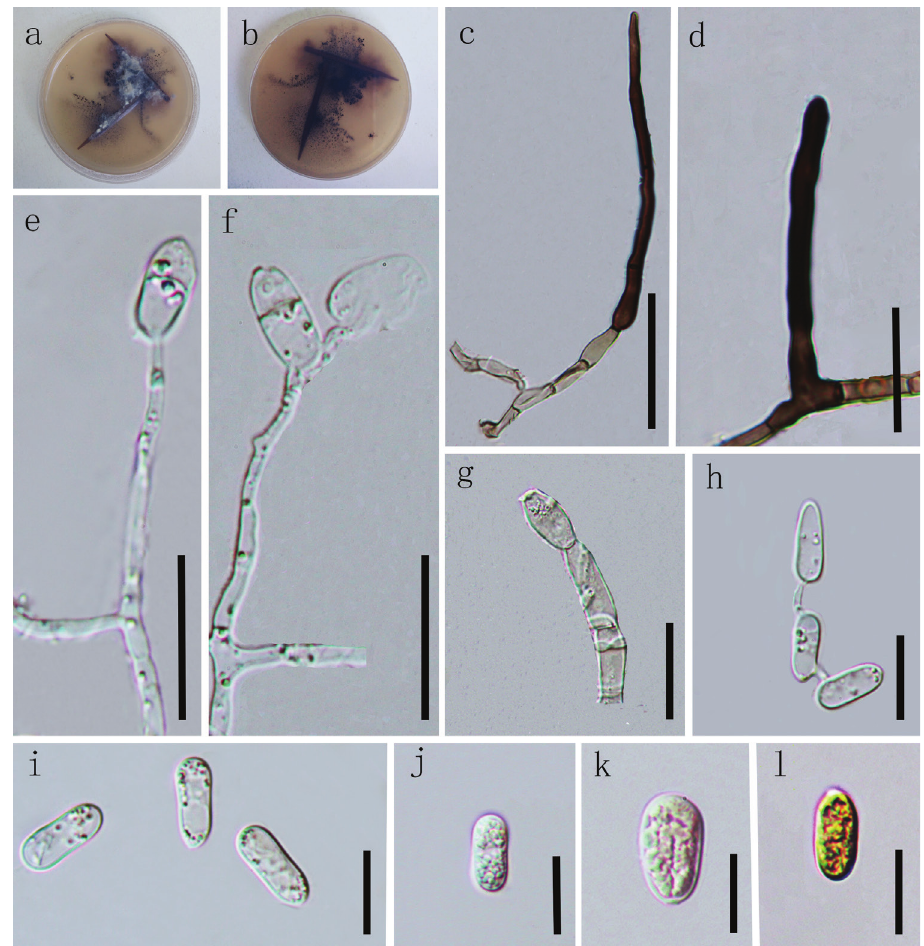
Figure 3. Colletotrichum tongrenense (GACP GZU_TRJ1-37, holotype) a, b colonies on WA c–g Con- idiophores h–l Conidia. Scale bars: 40 µm ( c ), 20 µm ( d, g ), 10 µm ( e, f ), 10 µm ( h–l